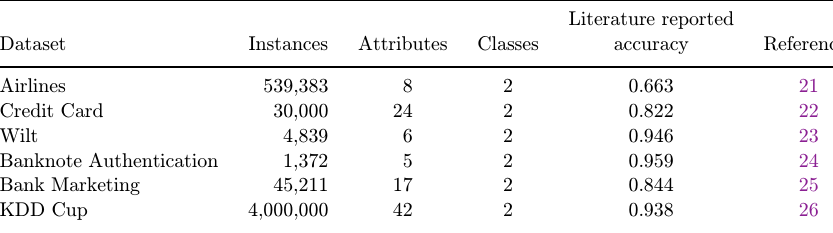
Table 1. Datasets used in the reported